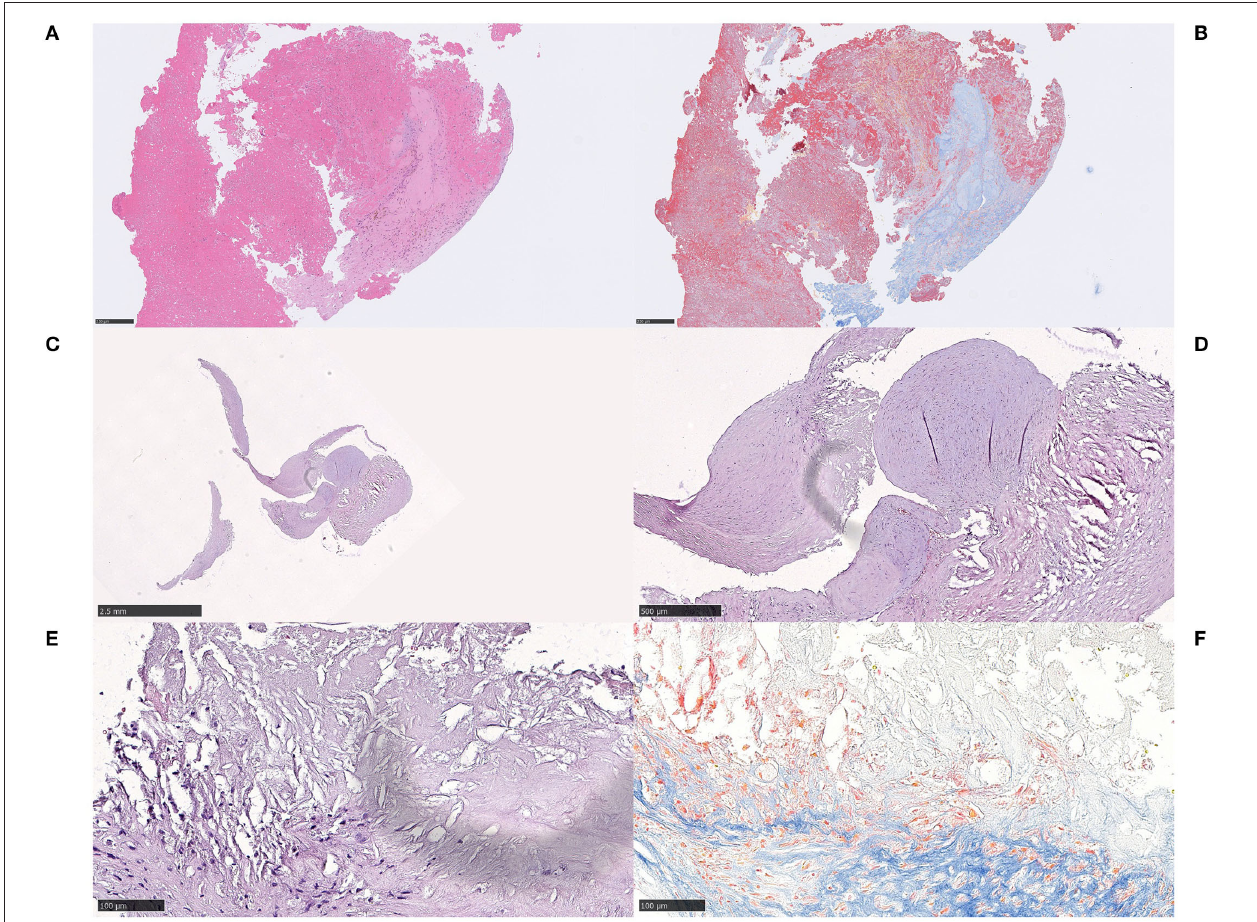
FIGURE 7 | Connective tissue. Case 4.1 Fibrin-rich thrombus showing dense and light reticular fibrin patterns and fibrosis on H&E (A) H&E, 100x and MSB (B) MSB, 100x. On high power (not shown), the connective tissue was seen with spindled cells within an eosinophilic, collagenous, and focally myxoid background. A radial growth of dense connective tissue extended between strands of fibrin. In the border zone to the fibrin component, macrophages, hemosiderin-containing macrophages and lymphocytes were morphologically identified and immunohistochemically verified. Case 4.2 Curved-shaped fragments of connective tissue, measuring several millimeters in length (C) H&E, 12,5x. Focally, there was necrotic debris surrounded by the cap-shaped fibrotic tissue, containing lymphocytes, macrophages and spindled-shaped cells in the immediate proximity to the necrosis, as a fibrotic cap (D) H&E, 50x. On high power, the necrosis contained cholesterol-like clefts (E,F) , H&E and MSB, respectively, 200x. All connective tissue within the fibrotic compartment was composed of spindled cells within an eosinophilic, dense collagenous background with collagen staining convincingly blue on MSB (not shown). The findings in case 4.2 indisputably indicate embolized atherosclerotic content, specifically parts of the fibrous cap that once encaged the central core of lipids and necrotic debris of an atherosclerotic plaque. Red blood cells, fibrin and platelets made up about 5% of the thrombus material altogether. For 12,5x, scale bar = 2,5mm; for 50x, scale bar = 500 µ m; for 100x, scale bar = 250 µ m; for 200x, scale bar = 100 µ